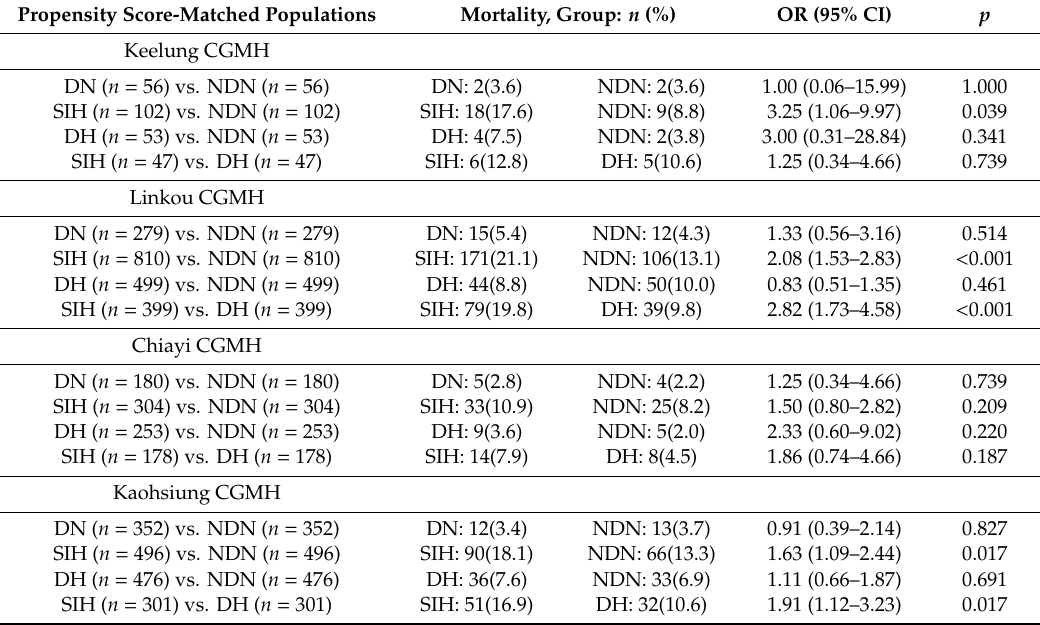
Table 4. Comparison of the mortality outcome among the four groups (NDN, DN, SIH, DH) within each hospital after propensity